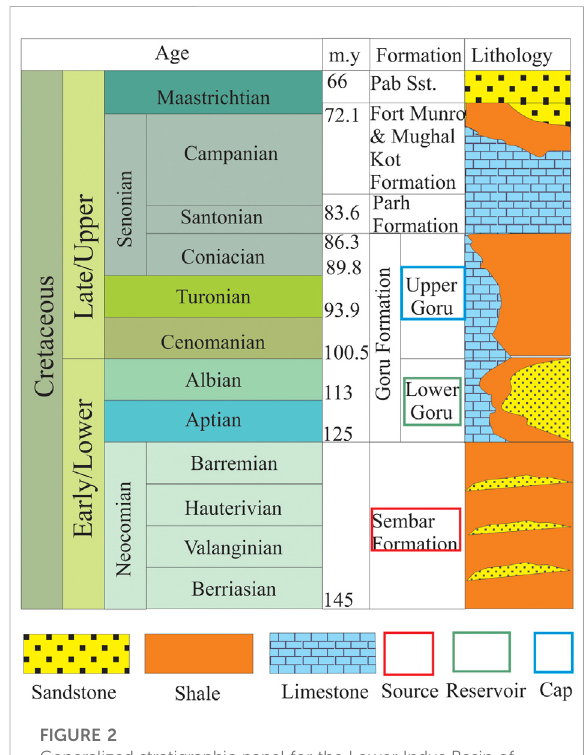
FIGURE 2 Generalized stratigraphic panel for the Lower Indus Basin of Pakistan modi fi ed after Yousaf